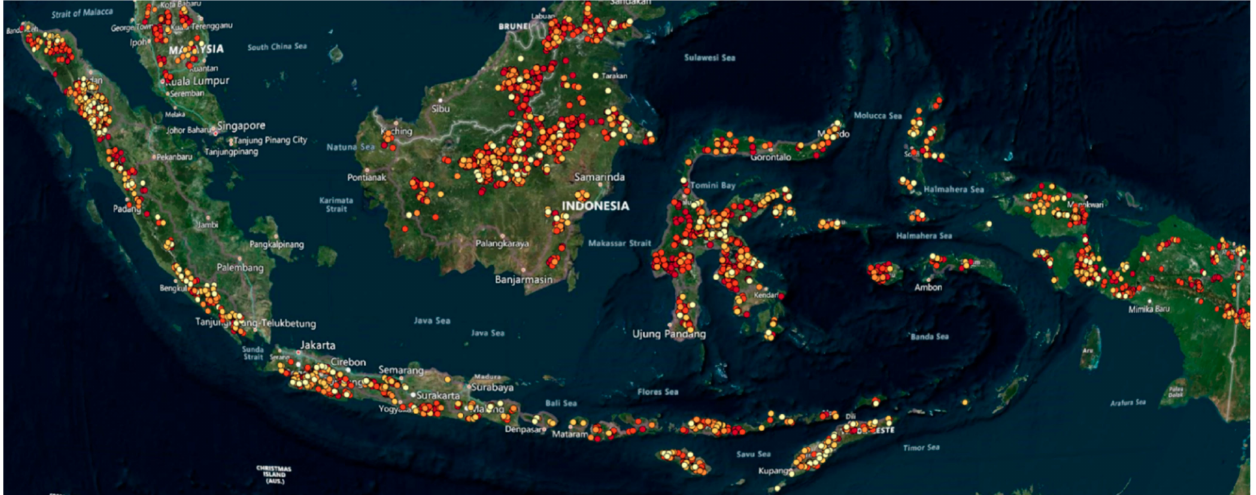
Figure 2. Potential 150 GWh Greenfield off-river pumped hydro energy storage sites in Indonesia (Source: [18], detailed zoomable map is available at NationalMap [18], Available onlne: http://re100 .eng.anu.edu.au/ (accessed on 1 March 2022)).